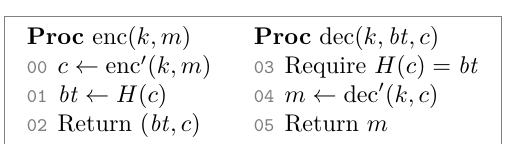
Figure 11: Construction of encryptment. If the condition in line 03 is not fulfilled, the dec algorithm fails.